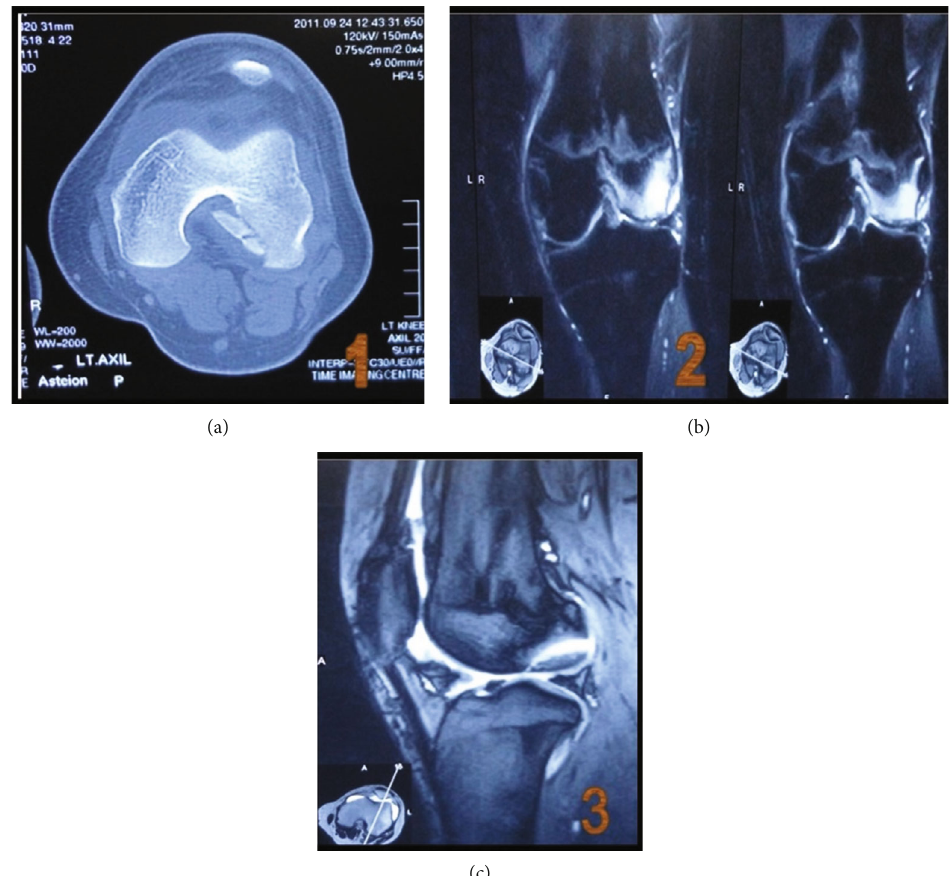
Figure 1: (a) CT scan notch view and (b, c) MRI image showing large defect at the posteromedial aspect of the lateral condyle femur.